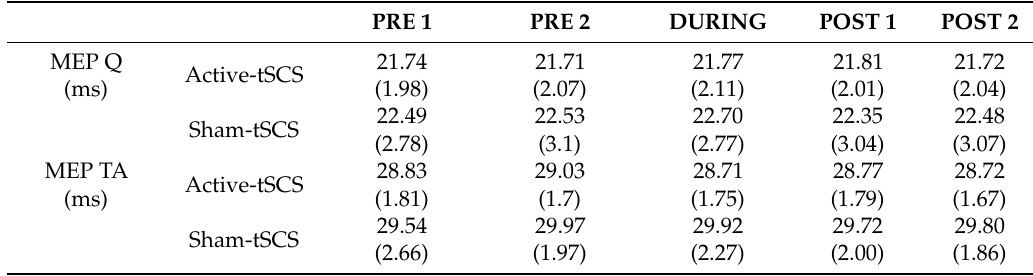
Table 2. Latencies MEPs following active-tSCS or sham-stimulation. Mean and standard deviation (SD).